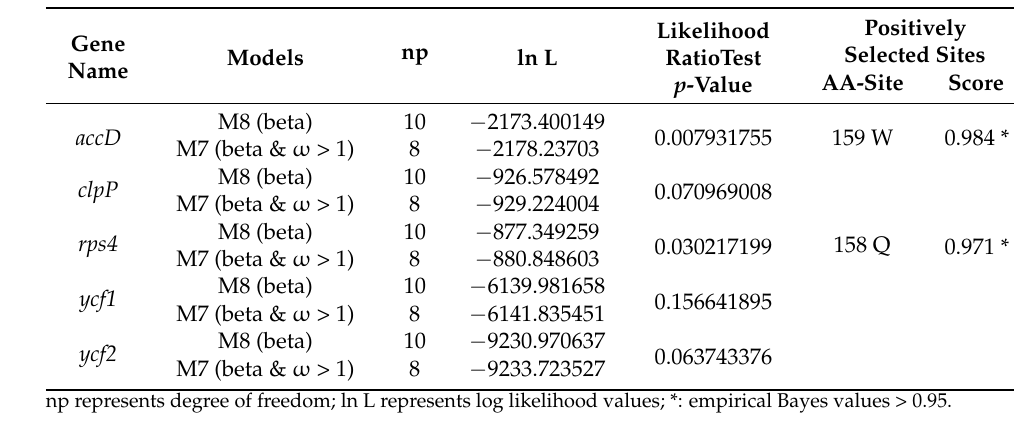
Table 3. Likelihood ratio tests of five potential genes under positive selection.